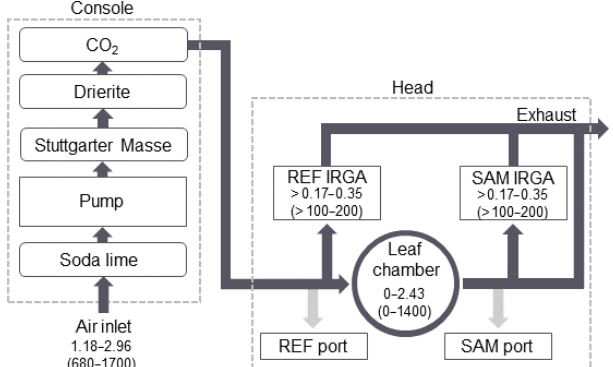
Figure 1. Flowchart of airflow through the PPS during emissions sampling. Dashed lines delineate flow through the PPS console and the head. Dark grey lines show the flow through the PPS during photosynthesis measurements. Light grey lines indicate the addi- tional flow path during emissions sampling. Values for flow rate are given in liters per minute (Lmin − 1 ), with micromoles per second (µmols − 1 ) in parentheses. The order of the chemical treatment of air is shown for the